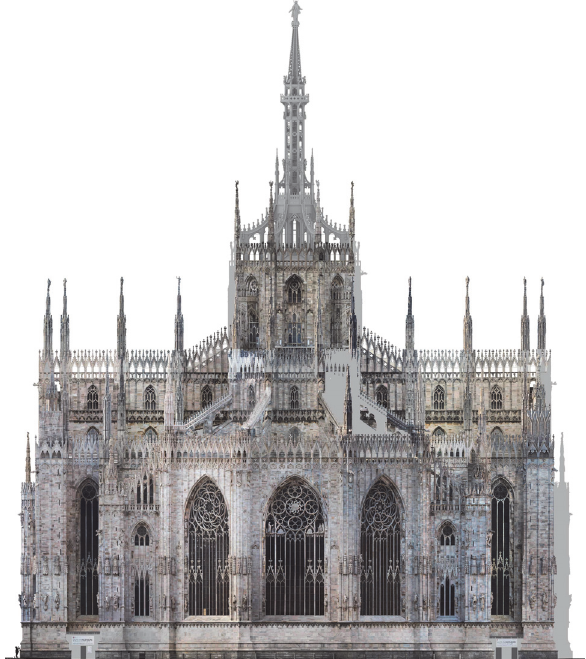
Figure 11: Orthophoto of the East Façade (apse) of the Milan Cathedral (April 2017) at 1:50 representation scale (4mm GSD). 3580 images taken using for different lenses. The orthoimages is the mosaic of 50 single orthophotos created only in a photogrammetric way during 574 hour of processing. The 3D DSM is about 1.5 billion of point. 40 GCP are used to